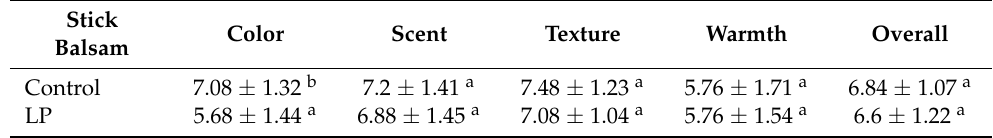
Table 3. Organoleptic results of spice stick